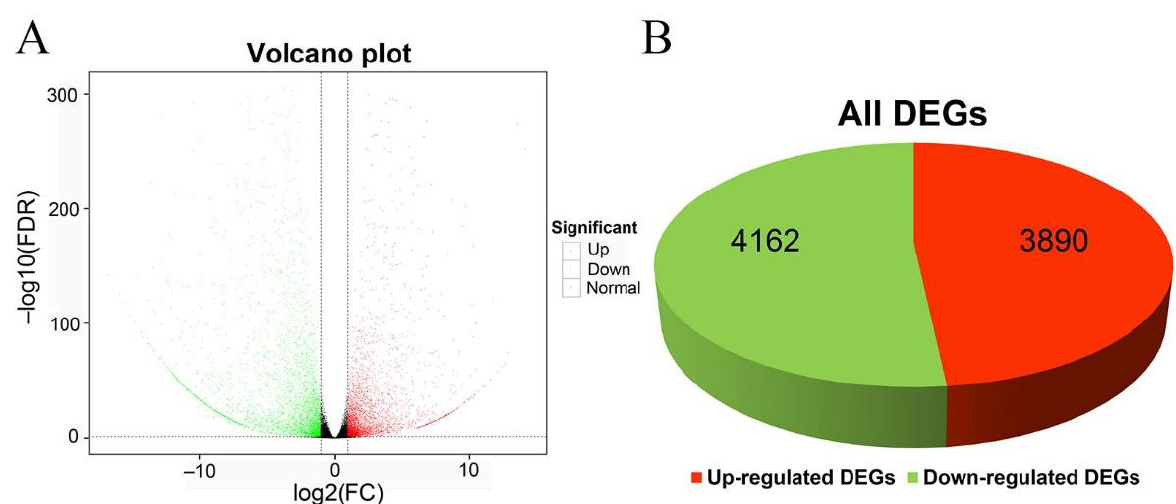
Figure 3. Differentially expressed genes (DEGs) in the Ogura CMS (Tyms) and its maintainer (231–330) lines; ( A ) volcano plot involving DEGs; ( B ) number of DEGs.